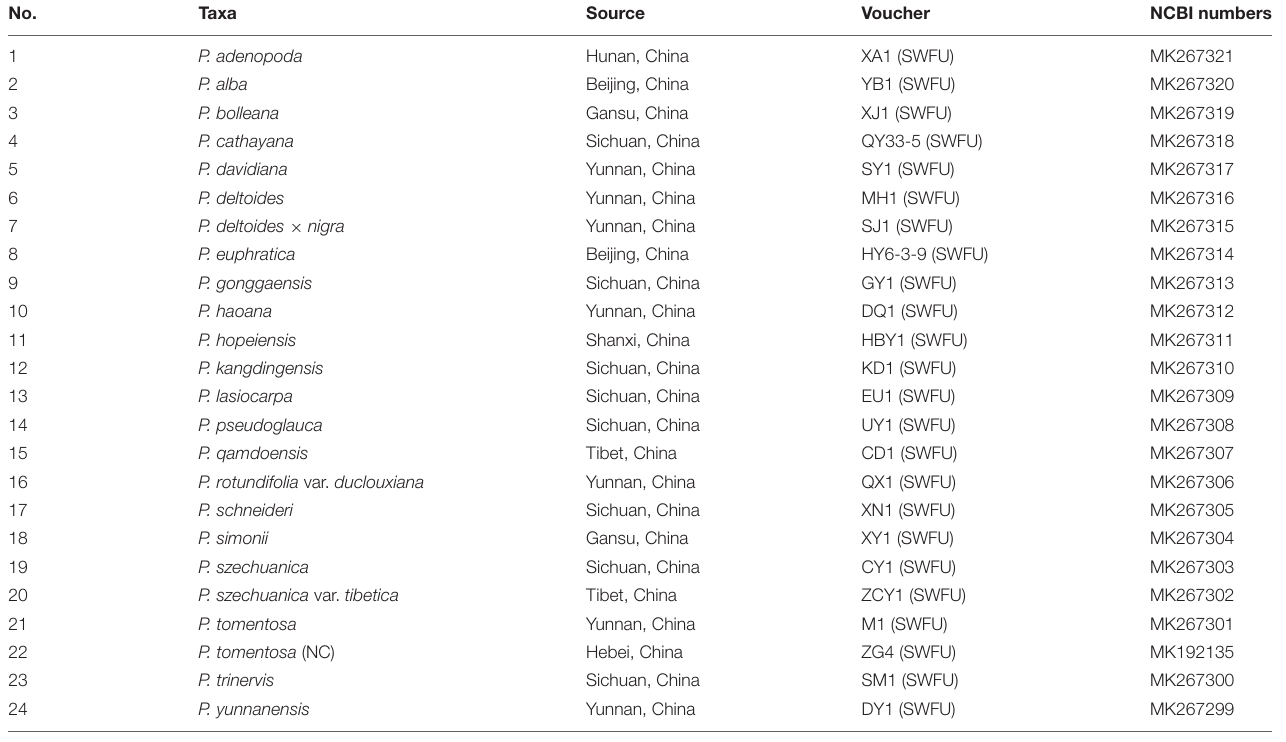
TABLE 1 | List of samples, voucher collection information and GenBank accession